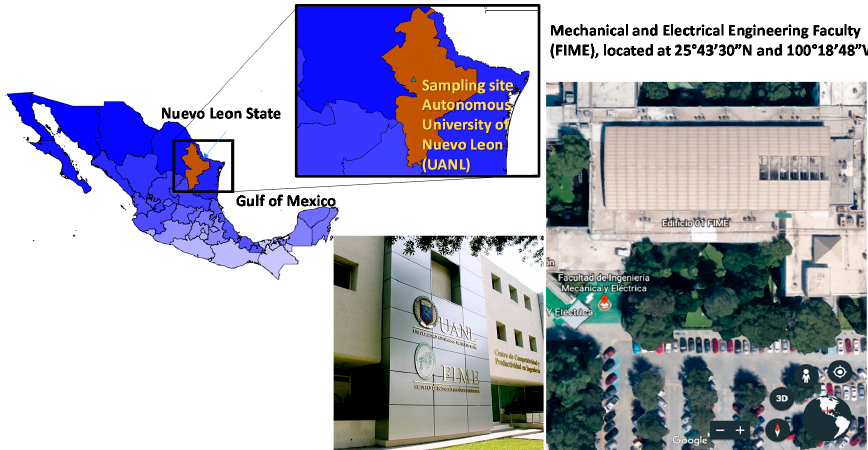
Figure 1. Sampling site location.